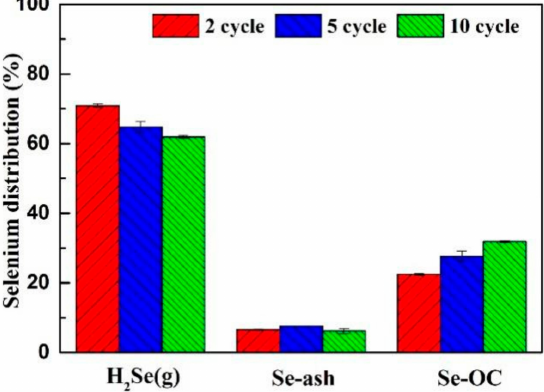
Figure 10. Variations of selenium distribution during a 10-cycle